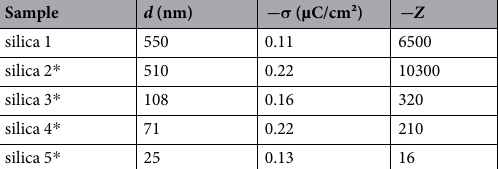
Table 1. Characteristics of the silica particles used in the study. * Labelled with green fluorescent dye.